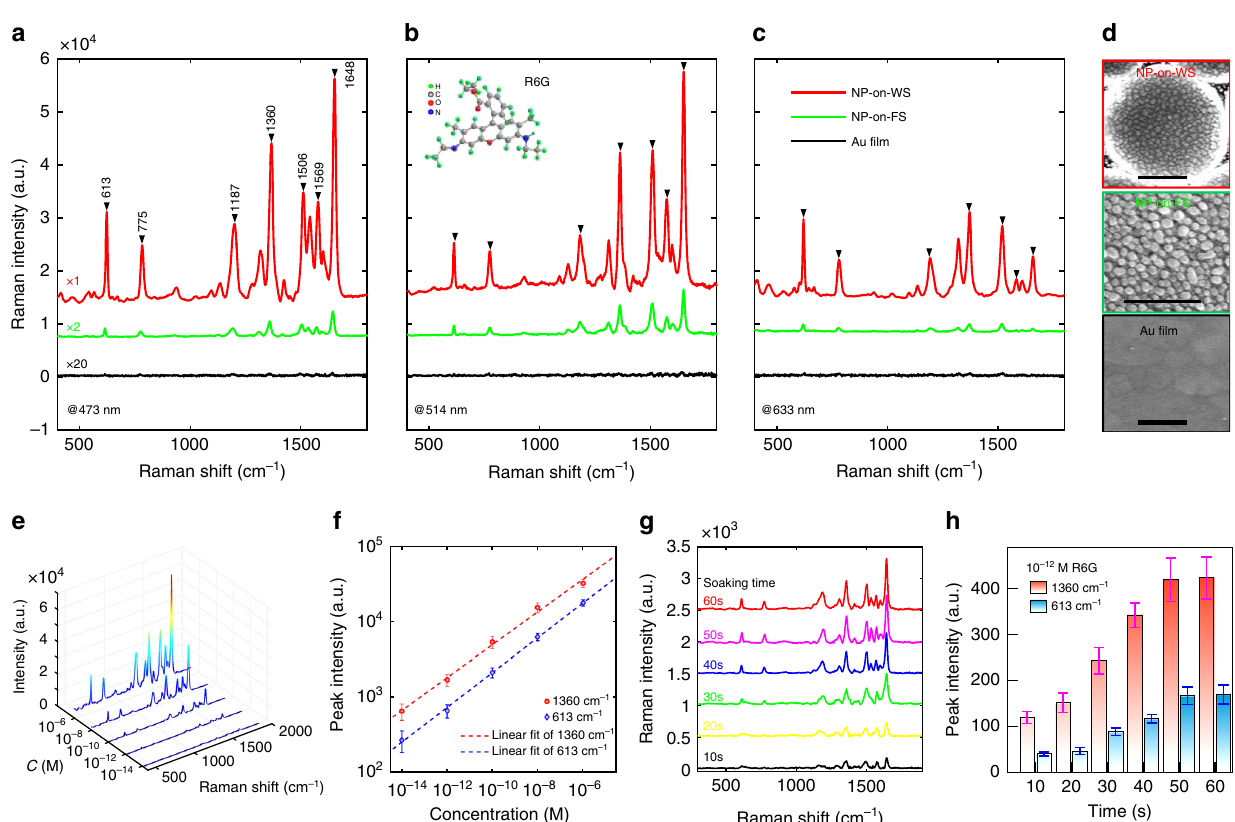
Fig. 3 TO-inspired SERS spectroscopy with broadband response, ultrahigh sensitivity and fast response on NP-on-WS structure. a – c The SERS spectra are shown for the NP-on-WS sample with different pump laser at ( a ) 473 nm, ( b ) 514 nm and ( c ) 633 nm. The signals from the reference ( fl at Au fi lm) and the control (NP-on-FS) are also demonstrated. d The corresponding SEM images of the NP-on-WS sample (top), NP-on-FS control (middle) and the reference (bottom). The scale bar represents 500 nm. e SERS spectra of R6G with fi ve different concentrations. Distinguishable peaks are demonstrated even at ultra dilute concentration of 10 − 12 M. The measurement for each R6G concentration is performed at fi ve different locations of the NP-in-NB substrate. f The SERS intensity of R6G peaks at 613 cm − 1 (red) and 1360 cm − 1 (blue) as a function of the molecular concentration in log – log scale. Error bars indicating the standard deviation of the peak intensities over different positions. A prominent linear relationship is presented with the fi t (dashed lines), demonstrating the potential for label-free quantitative sensing. g SERS spectra of R6G over substrates with different soaking times, with concentration of 10 − 12 M. Raman signals at 1360 cm − 1 are observed unambiguously even within 10 s. h The SERS intensity of R6G peaks at 613 and 1360 cm − 1 as a function of the soaking time. Error bars represent the mean value of three replicate samples